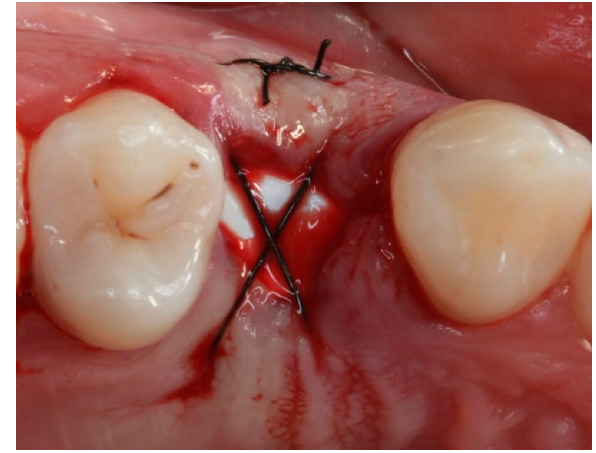
Figure 5. Intraoral occlusal view of the suture-stabilized membrane